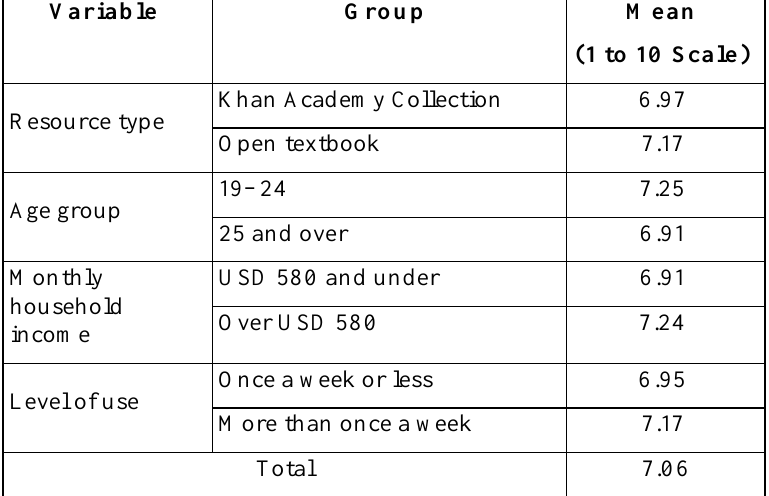
Mean OER Use Evaluation Index by Resource Type, Age Group, and Income Category ()